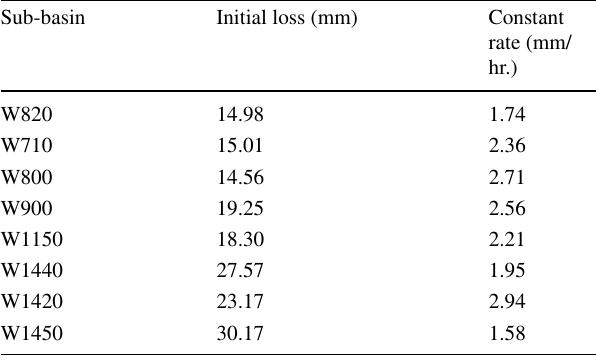
Table 6 Initial and constant loss model initial parameters Sub-basin